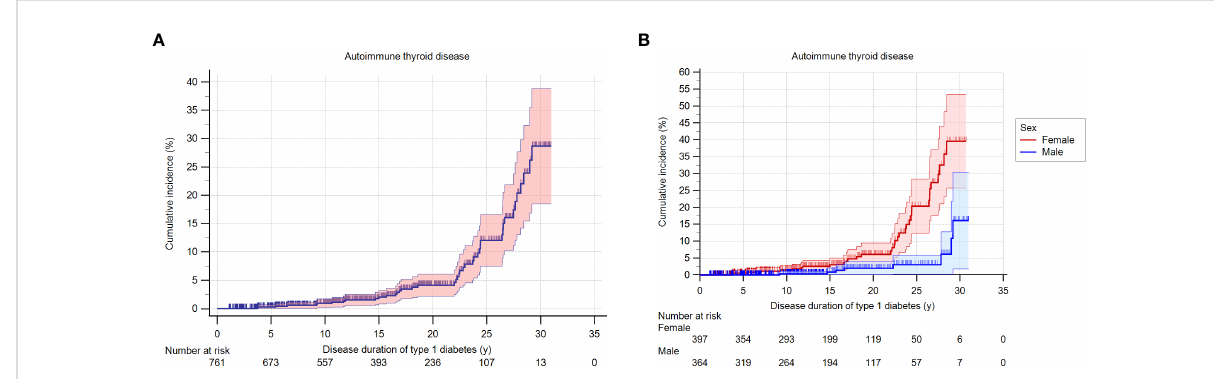
FIGURE 1 (A) . Cumulative incidence (probability) of AITD according to the duration of T1D in the whole group. (B) . Cumulative incidence (probability) of AITD according to the duration of T1D, strati fi ed by sex of the